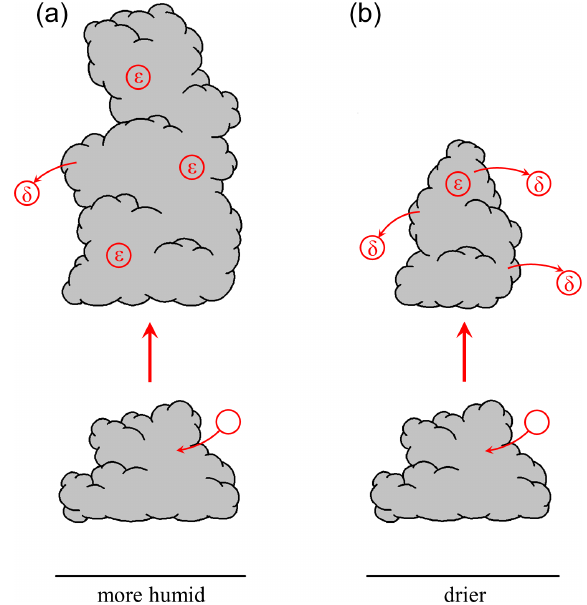
Figure 5. Schematic of cloud development in (a) more and (b) less humid environments. In drier environments, a larger fraction of entrained air becomes negatively buoyant and detrains, leaving a smaller